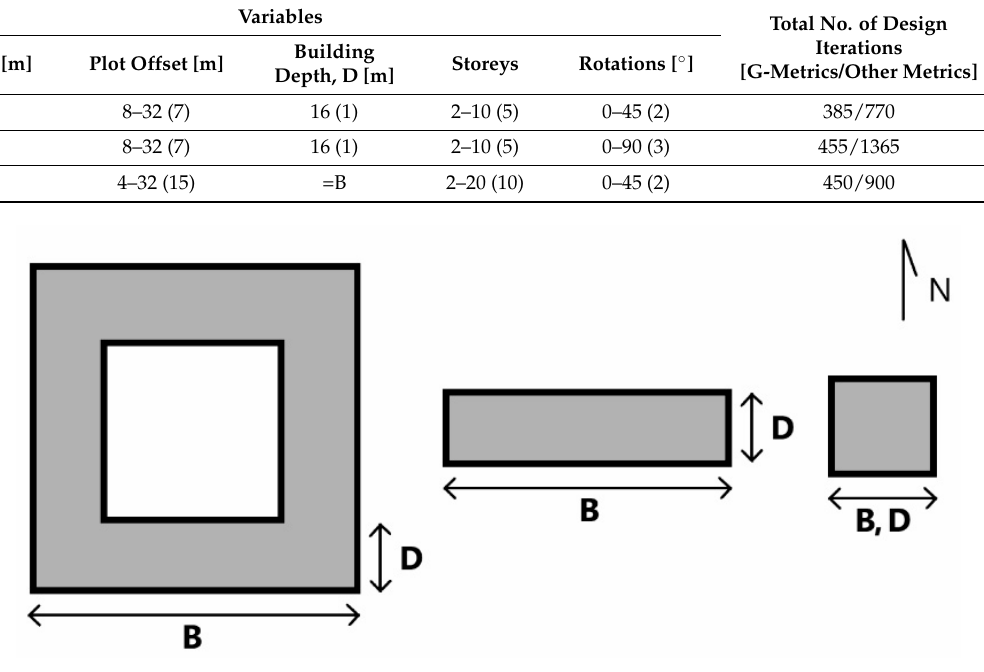
Figure 3. Courtyard, slab, and tower typologies (from left to right) presented in top view at 0° rotation: The letters ‘B’ and ‘D’ denote the dimension variables specified in Table 1.